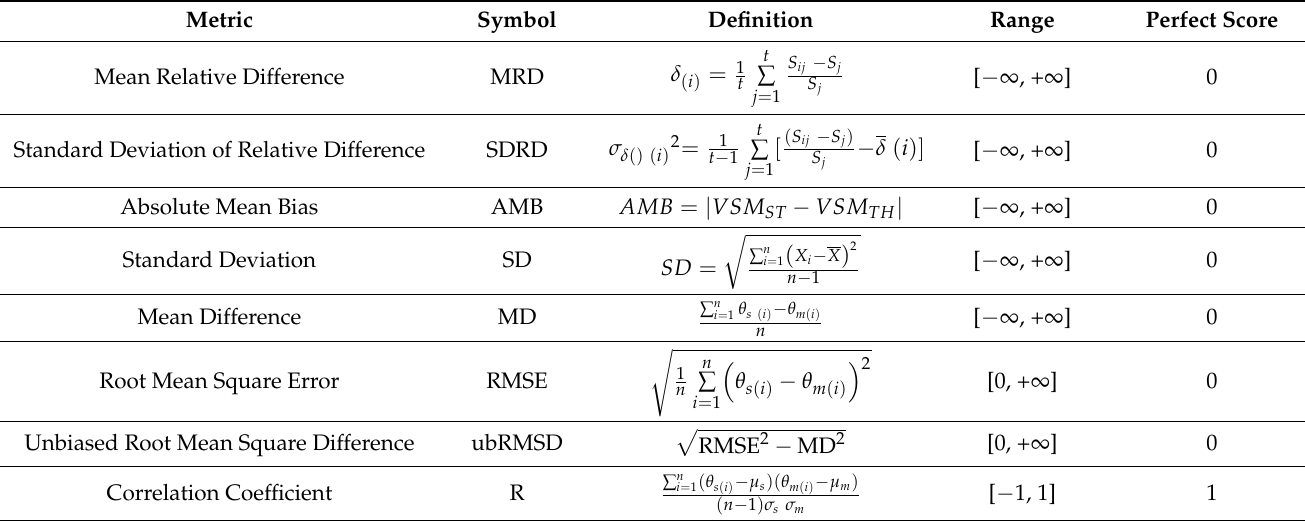
Table 1. Statistical metrics used for soil moisture